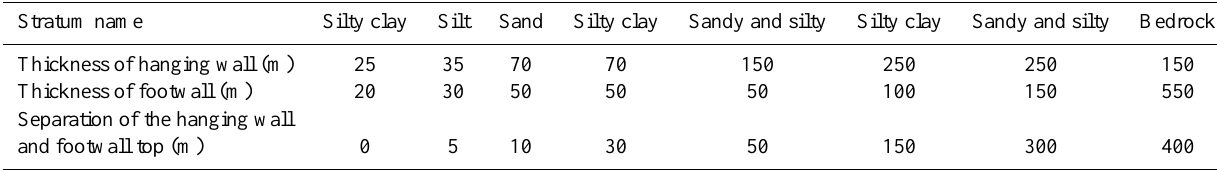
Table 1. The simplified strata used in the numerical model.